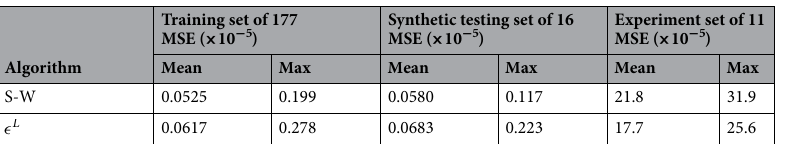
Table 1. Statistics of the goodness of fit between the PCA representation and the variation of the processed profiles, shown for the two databases. The training set corresponds to the synthetic profiles used to produce the principal components, the synthetic testing set corresponds to synthetic profiles withheld from the PCA, and the experiment set corresponds to the profiles taken from experiments.